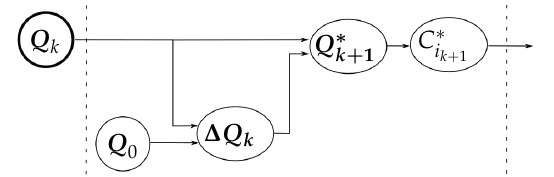
Figure 4. Variables involved in the optimization of the hand